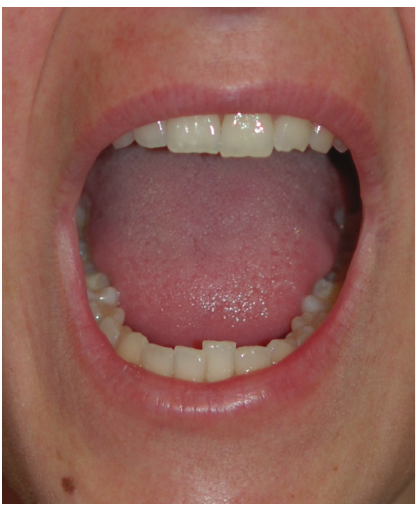
Figure 6: Follow-up at 1